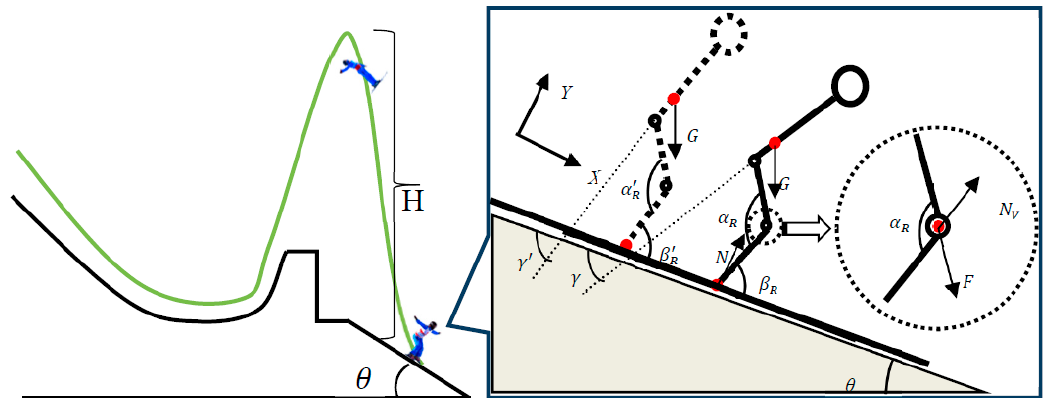
Figure 1. Freestyle skiing aerial motion curve and landing phase of the kinematic analysis diagram ( α (cid:48) and β (cid:48) represent the angles of the right knee and right ankle as landing begins, respectively, γ ’ was the angle between the torso and the landing slope. α R and β R represent the angles of the right knee and right ankle at the end of the balancing phase of landing, γ represents the angle between the torso and the landing slope at the end of the balancing phase of landing. H was the distance from the highest position of the trajectory to the landing position. θ was the landing slope angle. G was the force experienced by the athlete due to gravity, N was the reaction force from the landing slope, N v was the reaction force from the tibial plateau, F was the impact force from the upper part of the knee joint in the direction of the femur).